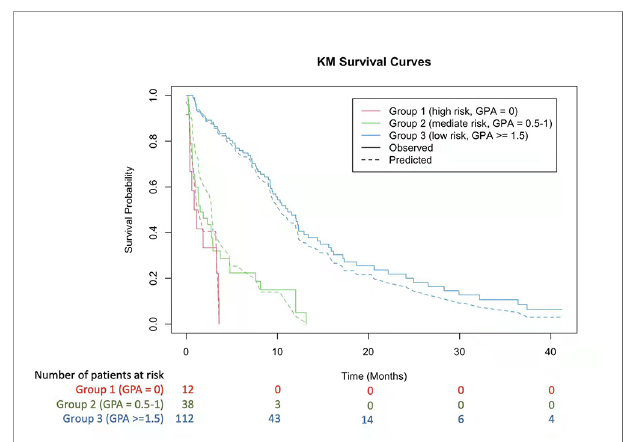
FIGURE 3 | Kaplan-Meier Curves Showing Survival using the 2022 molGPA for lung adenocarcinoma with LM. GPA, Graded Prognostic